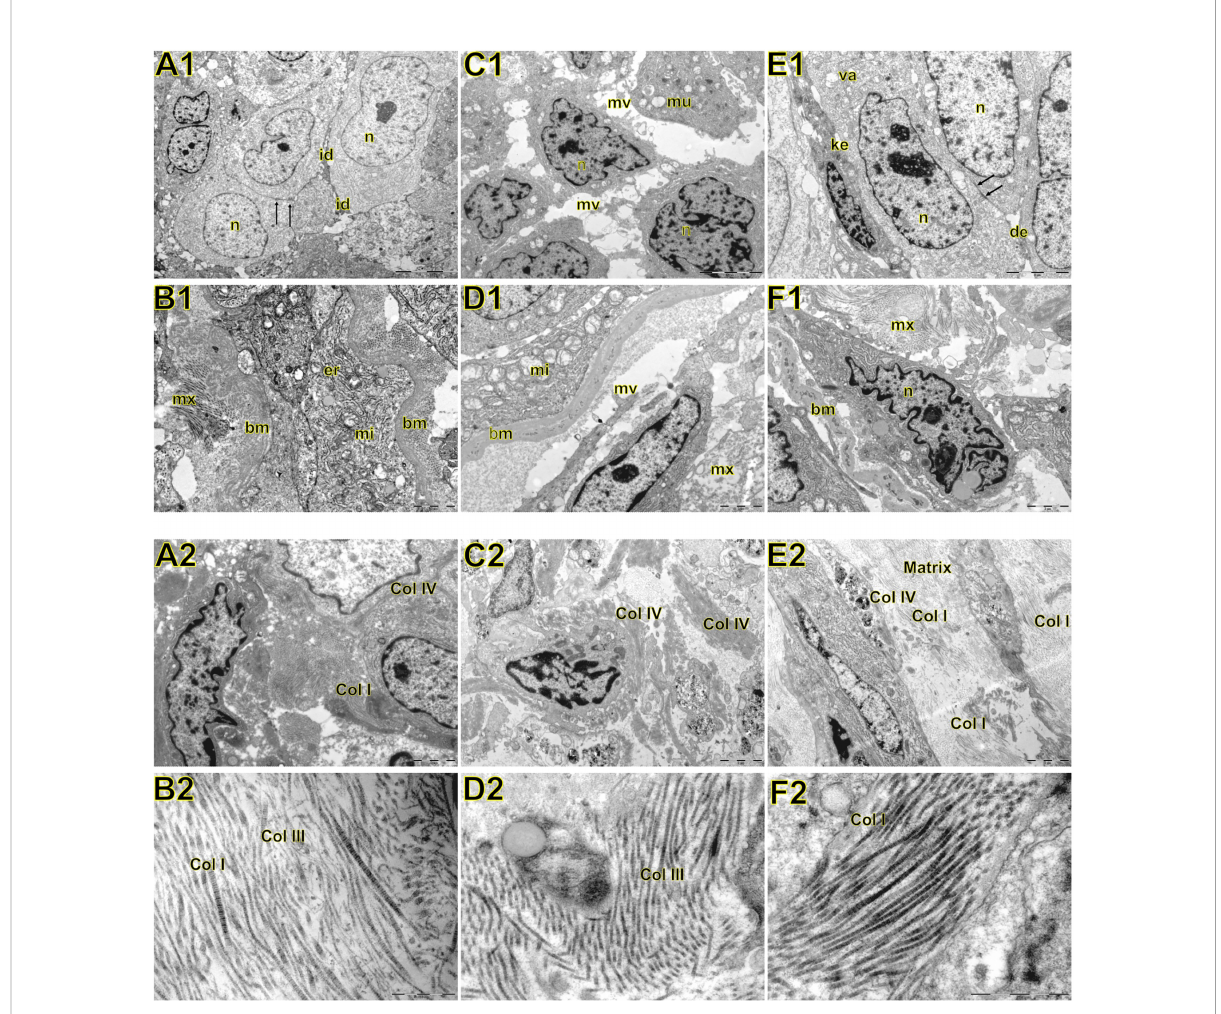
FIGURE 4 Transmission electron microscopy of large cell carcinoma (A, B) , adenocarcinoma (C, D) , and squamous cell carcinoma (E, F) visualized inside the tumor, basement membrane, and interstitial matrix. Above A1: large cell carcinoma showing large tumour cells with abundant light or little dark cytoplasm. Nuclei (n) are euchromatic and frequently display more or less deep invaginations with one to two prominent nucleoli. The cell membrane presented very short microvilli (mi) densely packed. Adjacent cells were interdigitated (id) with neighboring cells. In B1 , note invasive large cell carcinoma with prominent organelles including mitochondria (mi) and endoplasmic reticulum (er) protruding and dissecting the basement membrane (bm) to invade the surrounding matrix (mx). C1: adenocarcinoma showing round cells with marked irregularity of nucleus, light cytoplasm, and interdigitation by sparse and short microvilli (mv). Mucin vacuoles (mu) can be visualized disperses in the cytoplasm. In D1 , invasive cells protrude the basement membrane (bm) showing numerous organelles such as mitochondria (mi), and short microvilli projected toward the matrix (mx) assuming the fusiform phenotype. E1 : squamous cell showing cells partially cohesive by junctional complexes (desmosomes, des). Some cells exhibit a pale and regular nucleus (n) with evident nucleolus. Adjoined cells are connected by numerous adherens junctions (arrows) in their lateral domains showing cellular polarity. Some autophagosomes (va) can be observed in the cytoplasm. The dark cells exhibit keratin fi laments in the cytoplasm (ke). In F1 , invasive squamous cells assume elongated form, marked irregularity of nucleus dissecting basement membrane (bm) and collagen fi bers of the matrix (mx). Below A2: at low magni fi cation large cell carcinoma showing abnormal large tumour cells with abundant light or little dark cytoplasm, densely cohesive. In B2 , at high magni fi cation note the interstitial matrix composed buy fi brillar collagens (fc) intermixed in a scant amorphous matrix. C2 : a low magni fi cation of adenocarcinoma showing aberrant round cells with marked irregularity of nucleus, thick basement membrane matrix in the junction of tumor cells with the interstitial matrix suggesting invadopodium. In D2 , a high magni fi cation shows fi brillar collagen (fc). E2 : a low magni fi cation showing elongated invasive squamous cells with the amorphous collagen (ac) along the basement membrane matrix. The interstitial matrix is abundant and composed of fi brillar collagen (fc) immersed in an amorphous matrix composed of heparan sulfate and chondroitin sulfate. In F2 , a high magni fi cation exhibited mainly thick and distorted fi bers and micro fi brils of fi brillar collagen (fc) in the interstitial